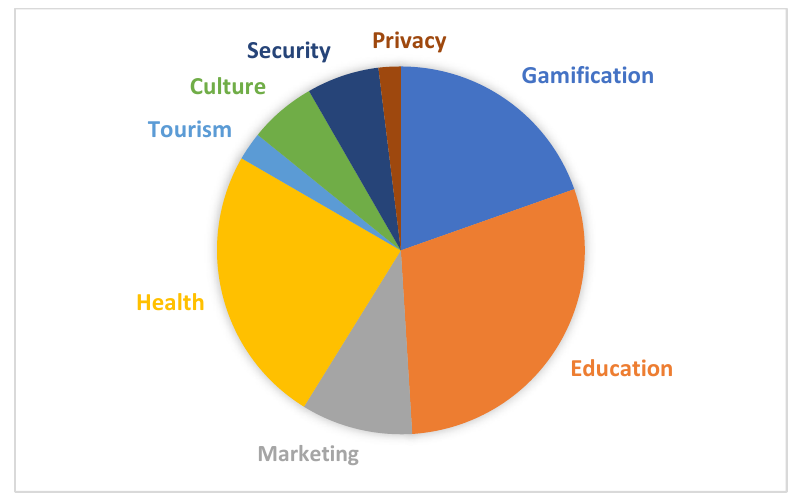
Figure 3. Results of search process. Table 4. Summary of the selection strategy.